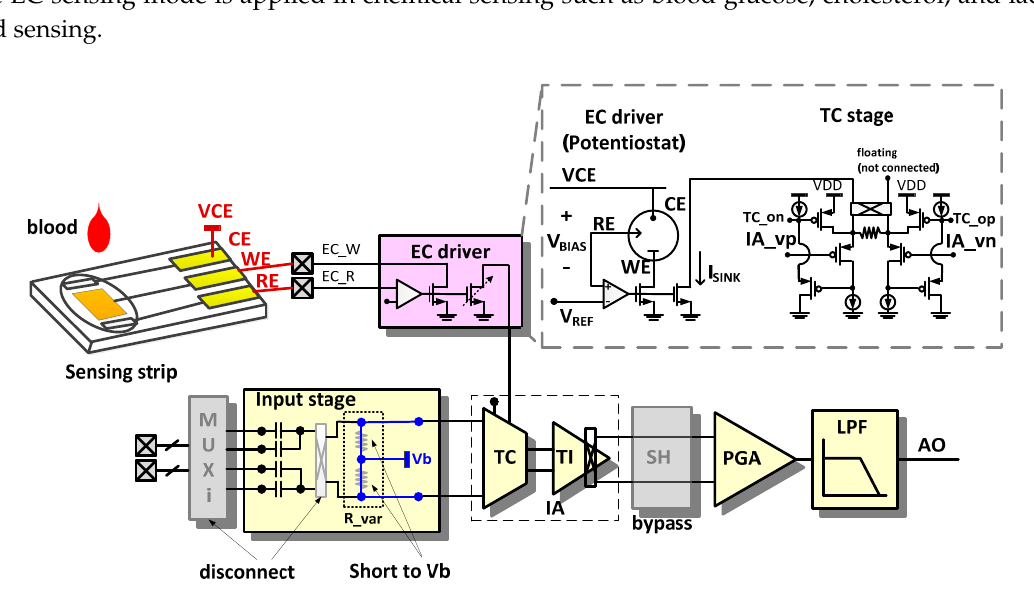
Figure 8. Reconfiguration of the readout channel for electrochemical (EC) sensing mode.